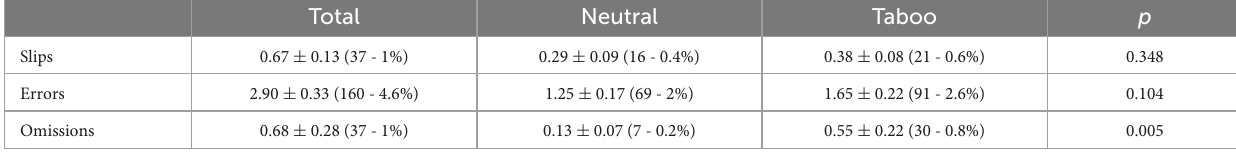
TABLE 1 Mean ± SEM by participants ( N = 55) for the total number of slips, speech errors and omissions in both neutral and taboo